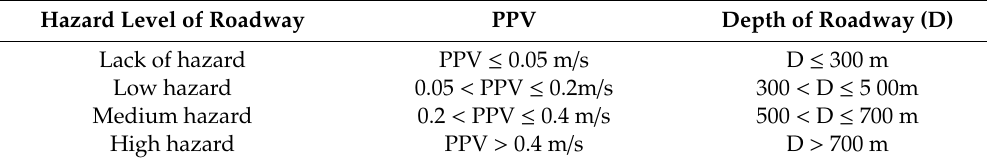
Table 3. Quantitative assessment of the impact of seismicity on the rock-burst potential [27,33].